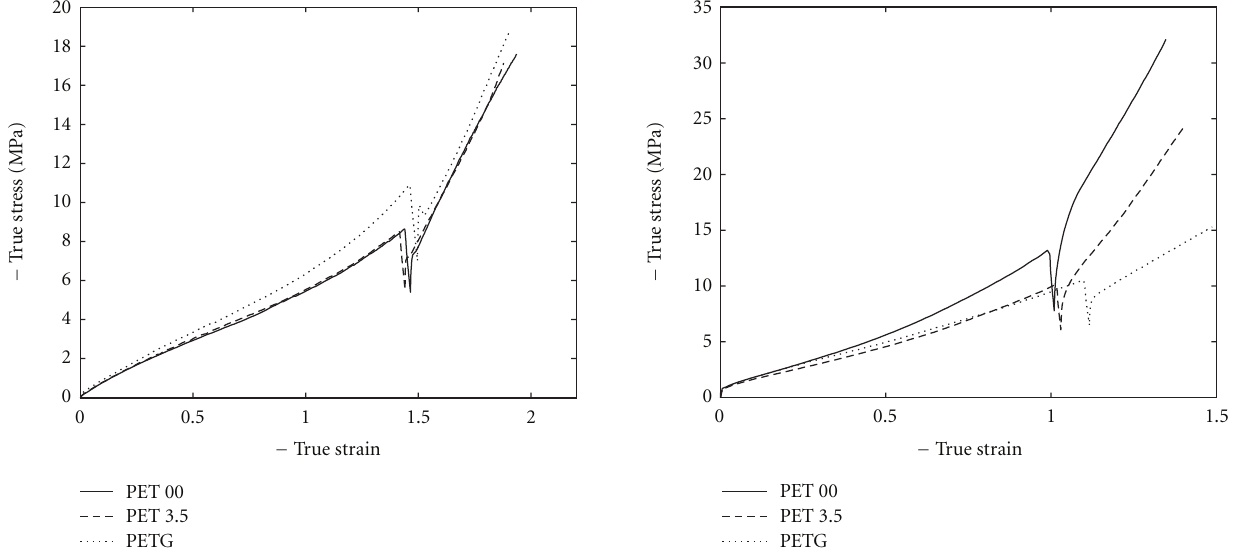
Figure 8: Material comparison, uniaxial compression at 90 ◦ C and 0.1/s, and hold at − 1.4.